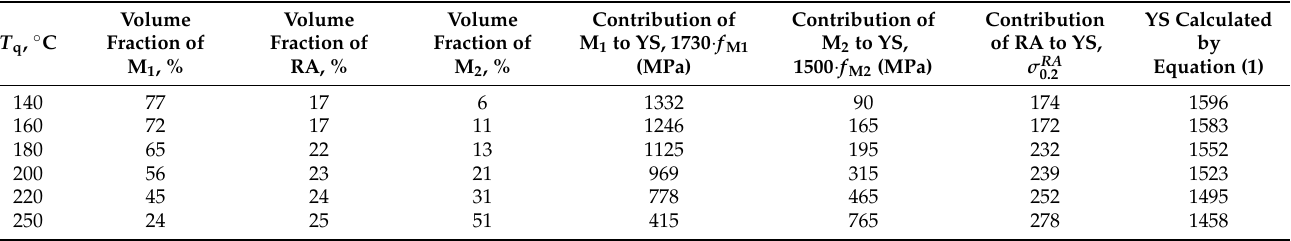
Table 4. Volume fractions of the primary martensite, secondary martensite, and RA calculated by Equation